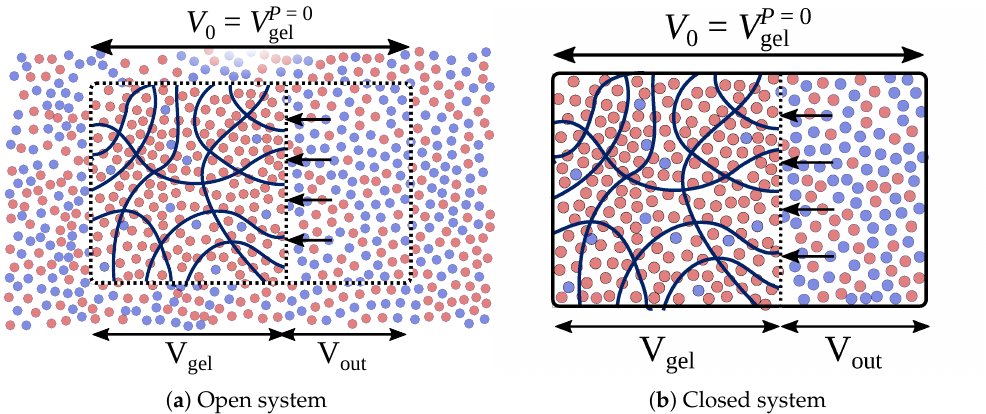
Figure 1. The hydrogel compressed in open and in closed system. Red and blue circles represent Na + and Cl − ions. V 0 is the volume which gel has in free swelling equilibrium